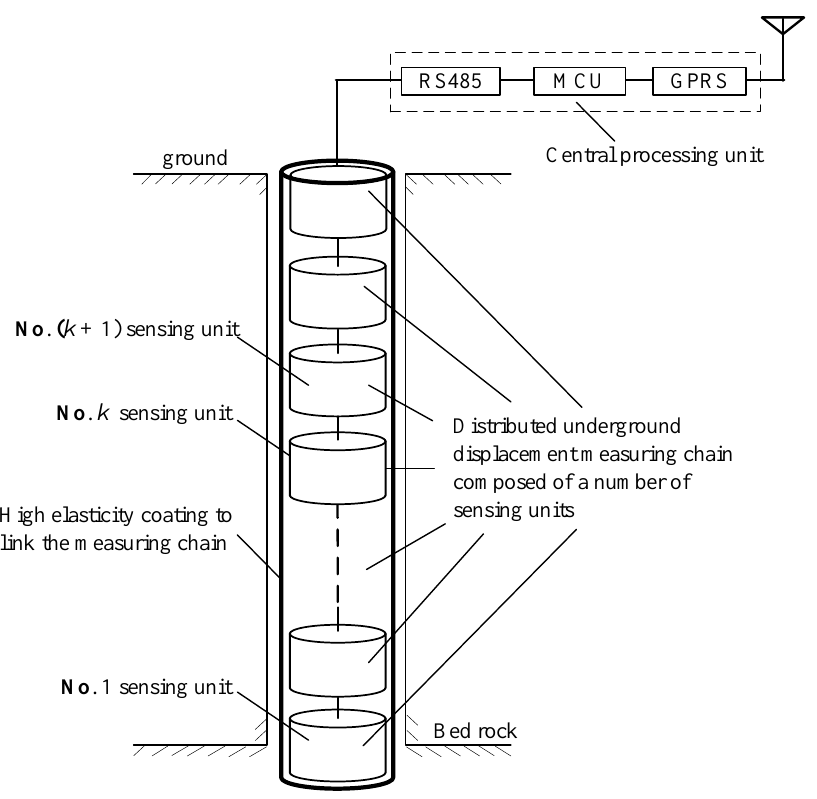
Figure 1. Schematic diagram of the electromagnetic underground 3D measuring sensor. GPRS, general packet radio